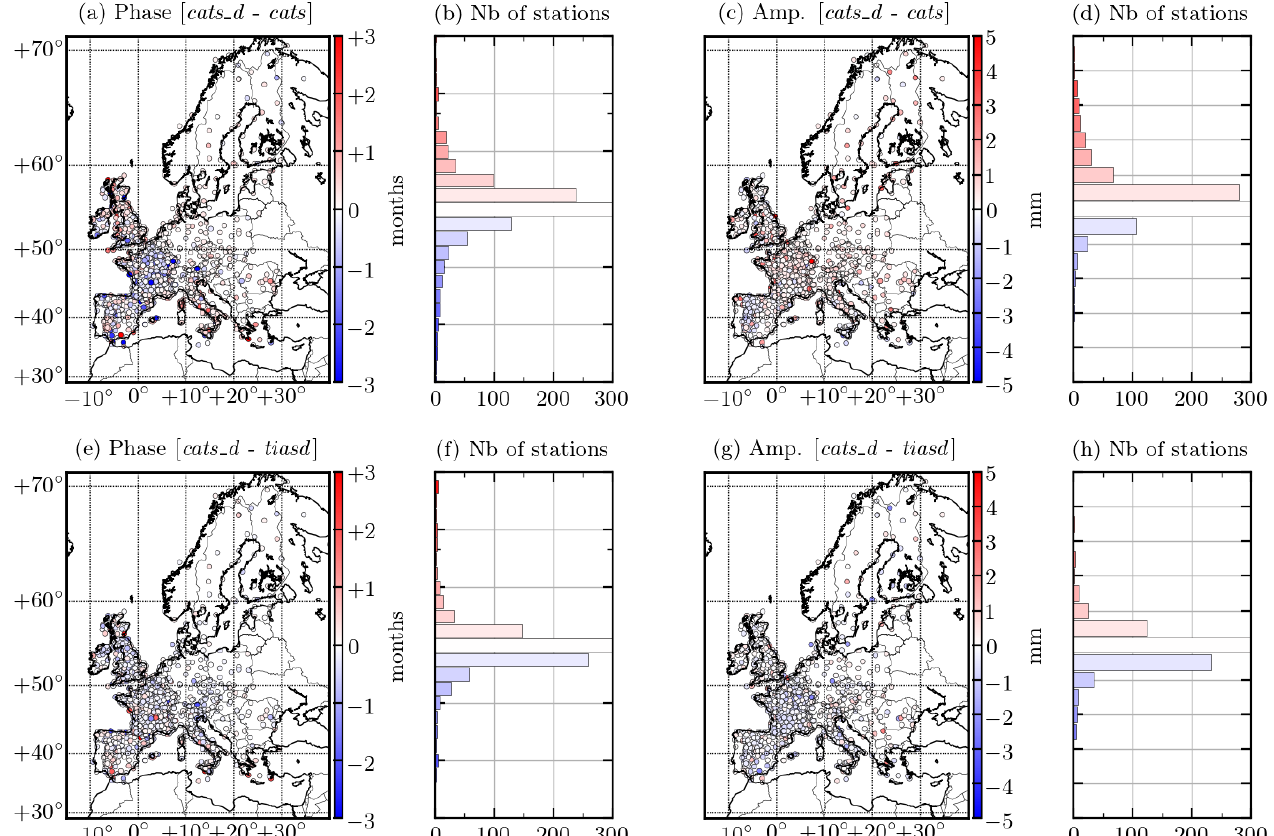
Figure 8. ( a – d ) Difference in annual solar cycle between cats_d and cats . Panels ( b , d ) represent, respectively, the number of stations where cats is in phase advance (blue) or delay (red) with respect to cats_d and the number of stations with larger (blue) or smaller (red) amplitude than cats_d . ( e – h ) are the same for the difference between cats_d and tiasd